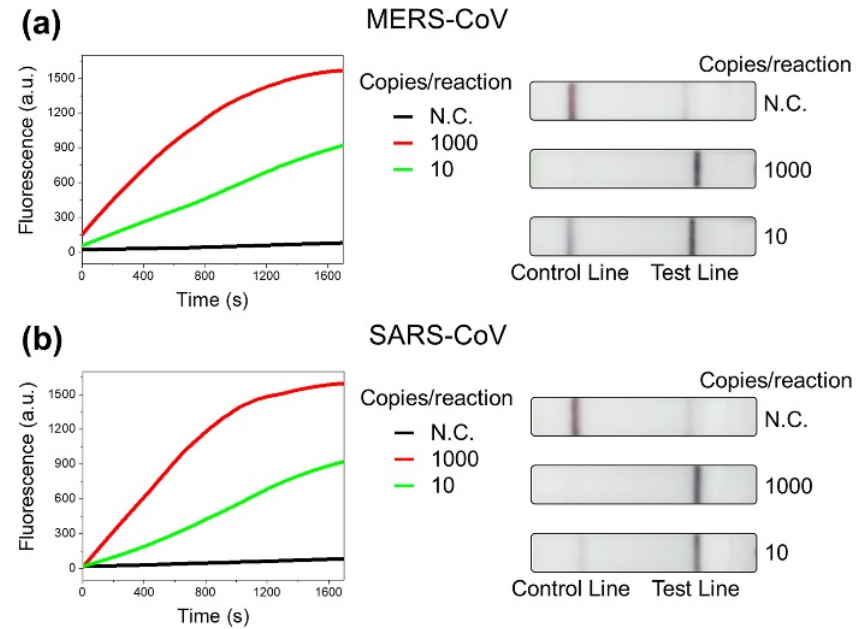
Figure 5. ( a ) Fluorescence and LFA detection results of synthetic gene of MERS-CoV using CRISPR- Cas12-based assay. ( b ) Fluorescence and LFA detection results of synthetic gene of SARS-CoV using CRISPR-Cas12-based assay. N.C. represents the results without samples.